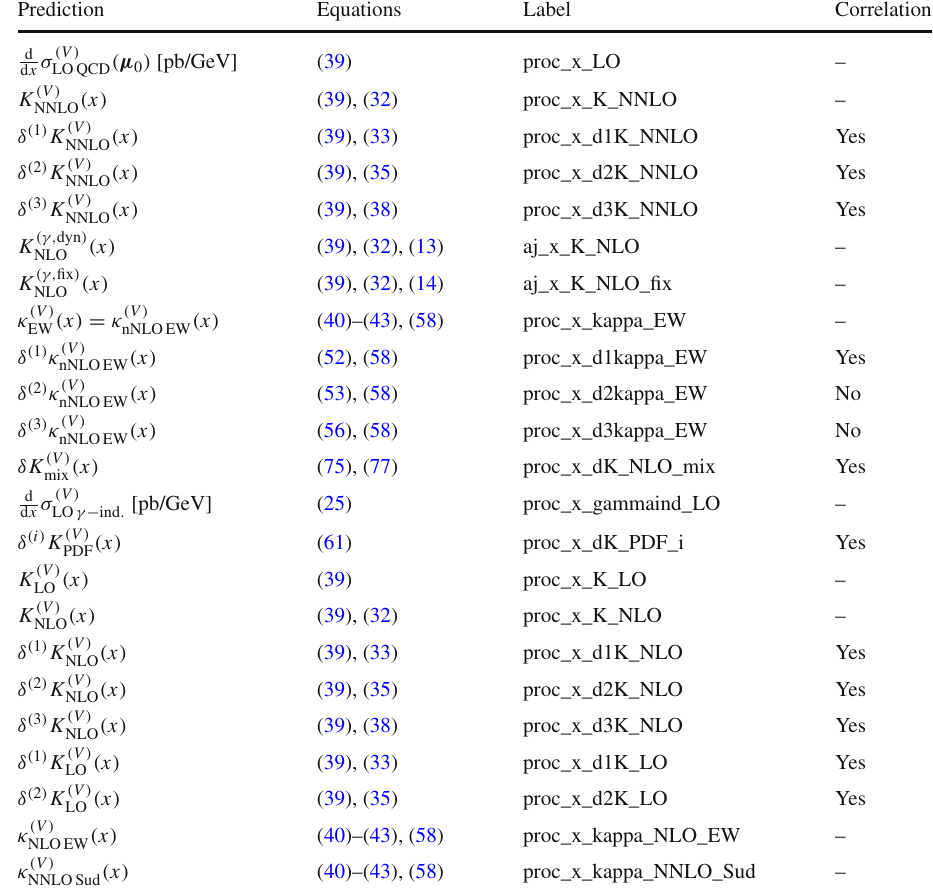
Table 3 Naming scheme for the theoretical predictions and uncertainties described in Sect. 4. The upper part lists the highest available perturbation order, while the predictions in the lower part are included for completeness. The last column indicates the correlation of the uncertainties across different V + jets processes. The actual distribution names are x=pTV and the individual processes are available in the files proc.dat with process